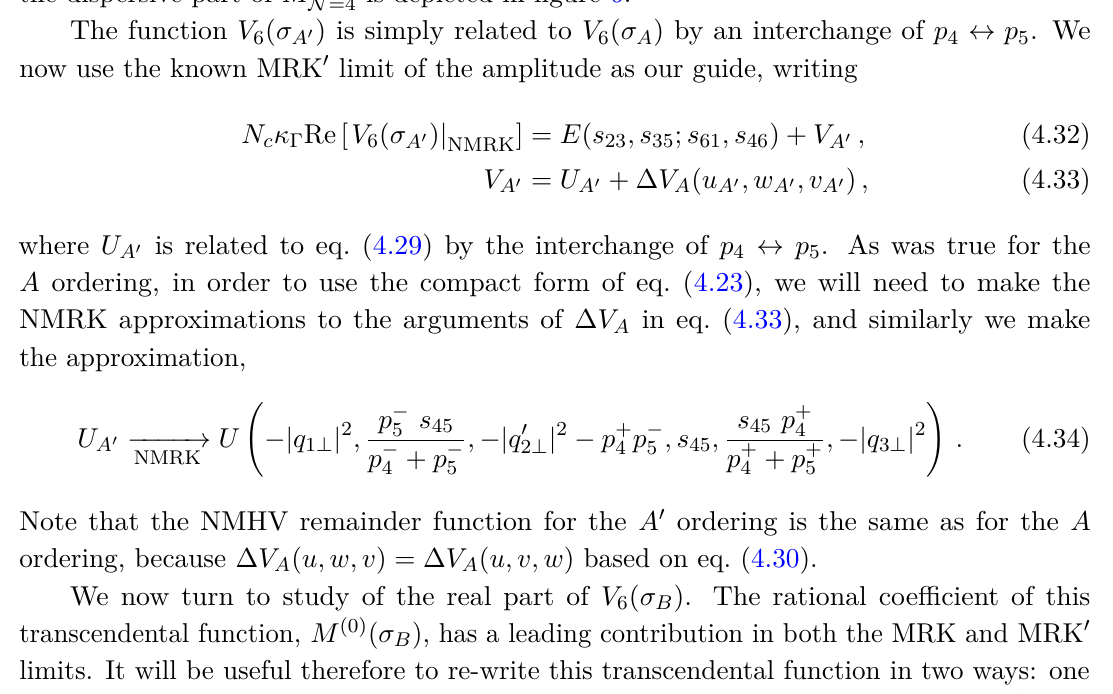
Figure 6 . Schematic illustration of the behaviour of the dispersive part of the one-loop partial amplitude M (1) ( σ ) in the central NMRK limit. The first diagram on the right-hand side represents A N =4 the transcendental functions that depend on the central degrees of freedom, V the one-loop correction to the two-gluon CEV for this colour ordering. The remaining four diagrams on the right-hand side are given by the known one-loop impact factors and gluon Regge trajectory contributions, and are collected in the function E of eq.